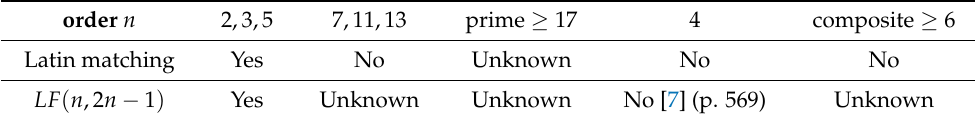
Table 1. On the existence of LF ( n ,2 n − 1 ) and Latin